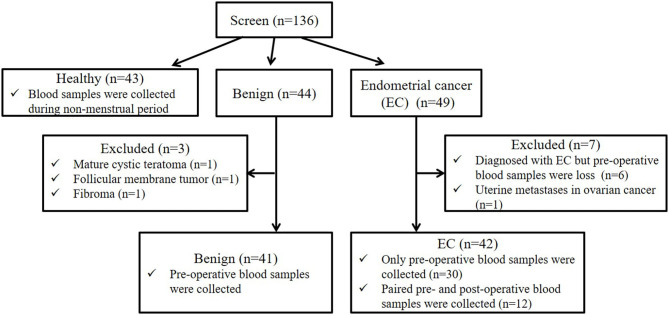
Participant screening flow chart. We screened 136 participants, including 43 healthy women, 44 benign and 49 EC patients. Among 44 benign patients, 3 patients with other tumors were excluded. Among 49 EC patients, 6 EC patients lacked pre-operative blood samples, and 1 patients with metastatic EC were excluded. Among 42 patients included in the EC group, paired pre- and post-operative blood samples were obtained from 12 patients.